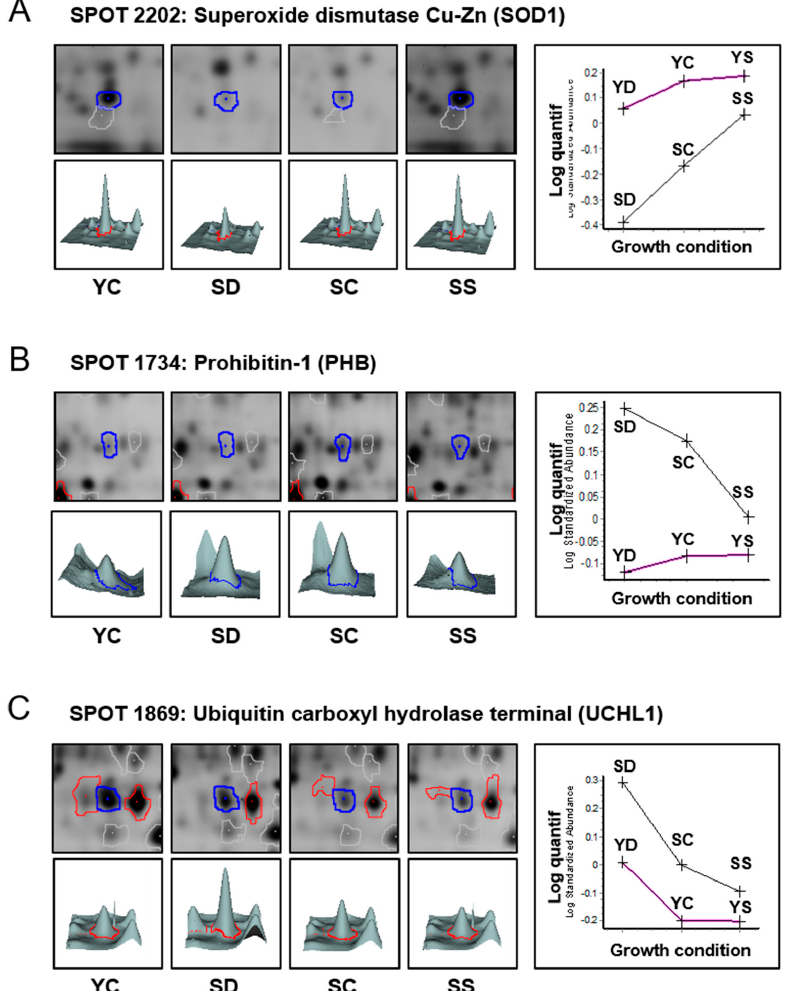
Figure 4. Figure 4. Typical examples of 2D spots differentially regulated by senescence and selenium levels of the culture media. Respective spot maps in 2D (top panels) and 3D (bottom panel) and average quantification (right graphs) are shown for spots number 2202 ( A ), 1734 ( B ), and 1869 ( C